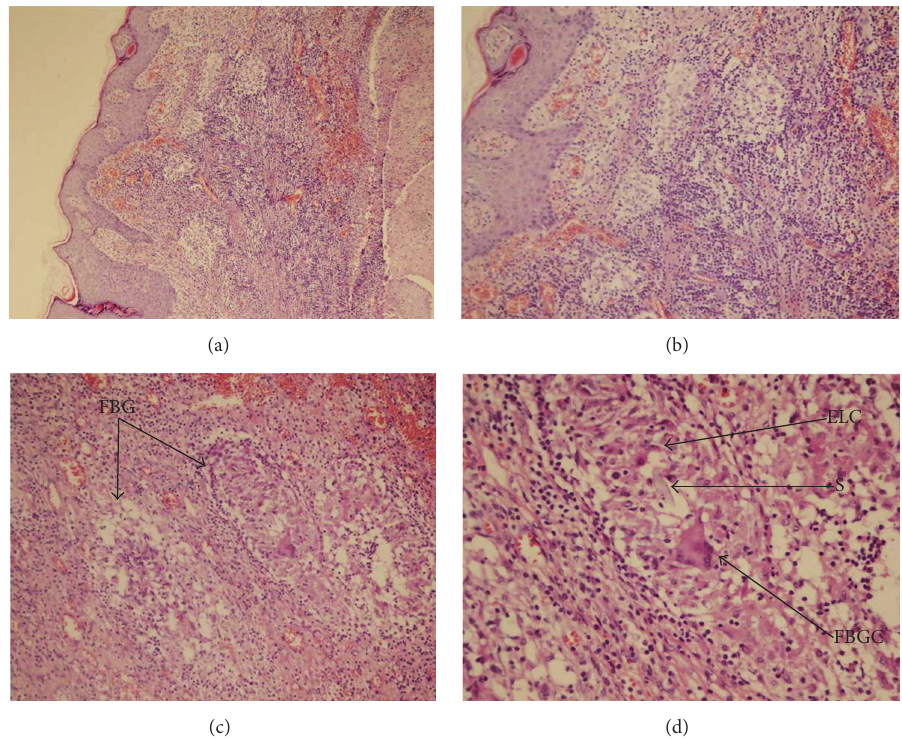
Figure 3: Photomicrograph. (a) Sinus parietal pathology HE × 100; (b) sinus parietal pathology HE × 200; (c) foreign body granuloma formation HE × 200; (d) foreign body granuloma formation HE × 400; FBG: foreign body granuloma; ELC: epithelial-like cell; S: suture; FBGC: foreign body giant